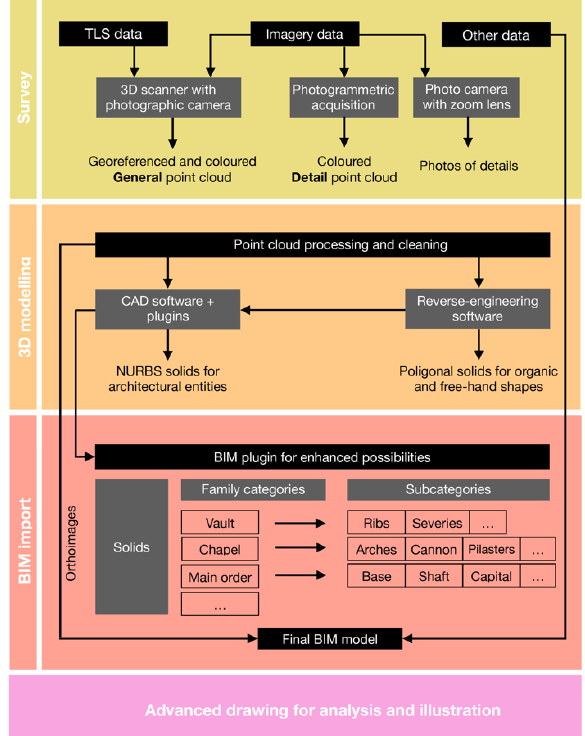
Figure 3. Concept map of the proposed